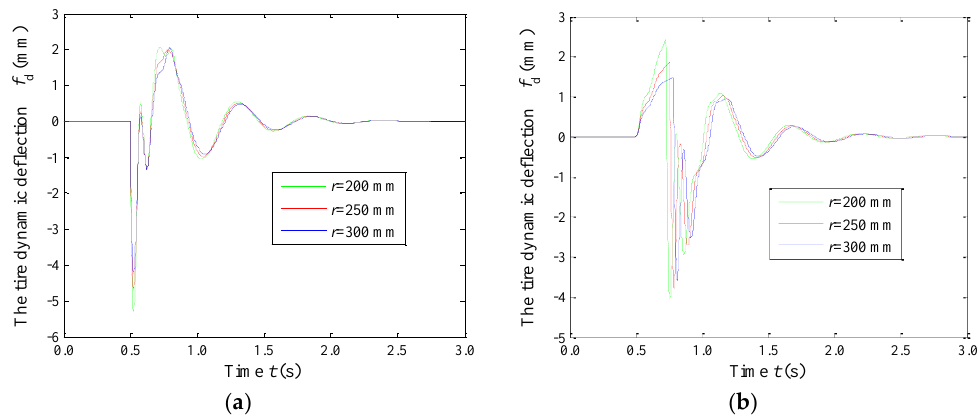
Figure 12. A comparison of the time histories of the human body acceleration a 2 at different values of r for the wheelchair: ( a ) going up the step; ( b ) going down the step.